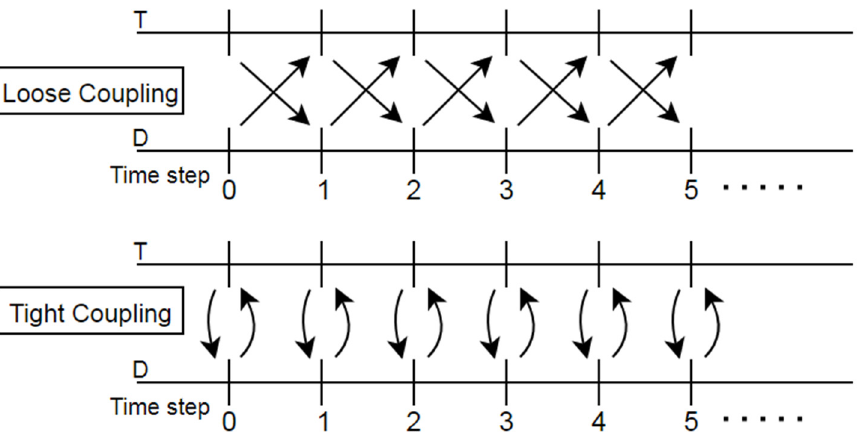
Figure 3. Coupling mechanisms employed for integrated T&D co-simulations.